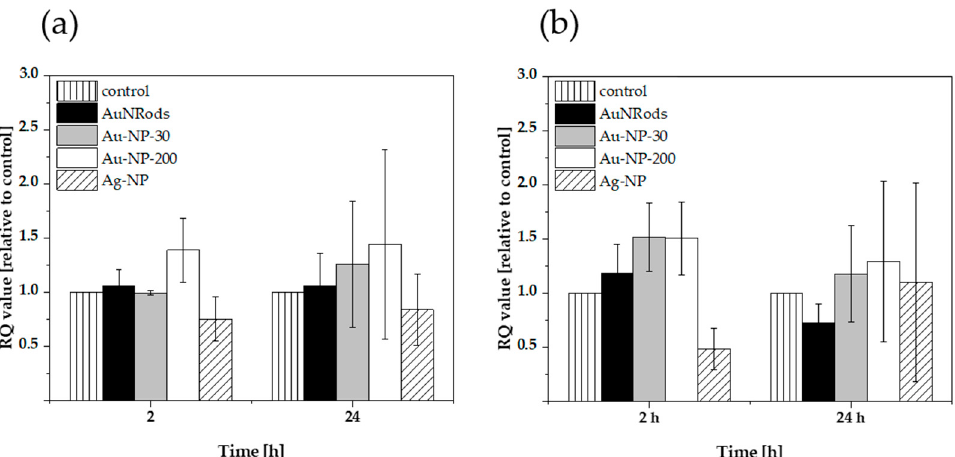
Figure 8. ROS generation in the gastrointestinal in vitro model after 2 h and 24 h incubation with mNPs. The in vitro model was exposed to 1 µg/mL AuNRods, AuNP-30, AuNP-200 and 30 µg/mL AgNP. Afterwards, the expression of Catalase (CAT) and Glutathioneperoxidase (GPX1) in the apical cells (Caco-2 and HT29-MTX) was determined via qPCR. ( a ) CAT expression; ( b ) GPX1 expression. n = 3.